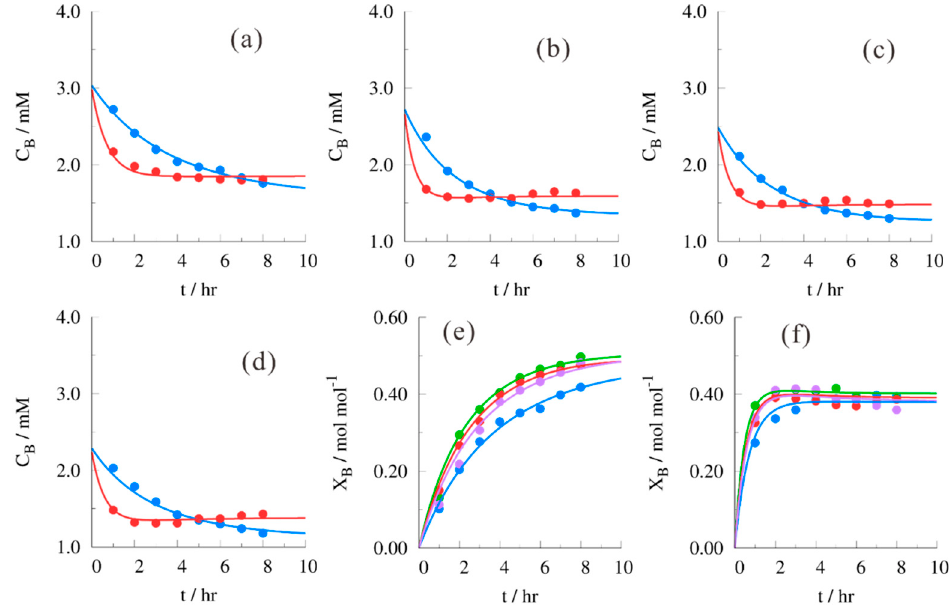
Figure 4. (I) Concentration of reactant B as a function of reaction time for (B / H) 0 = 1 mol · mol − 1 . Solvent = ( a ) methanol; ( b ) ethanol; ( c ) n-propanol; ( d ) n-butanol; T = ( ─ , ● ) 80 °C, ( ─ , ● ) 120 °C. (II) Conversion of B as a function of reaction time for ( B / H ) 0 = 1 mol mol − 1 at ( e ) 80 °C, and ( f ) 120 °C with the solvent ( ─ , ● ) methanol, ( ─ , ● ) ethanol, ( ─ , ● ) n-propanol, ( ─ , ● ) n-butanol. Points and lines are obtained as described in Section 3.2.